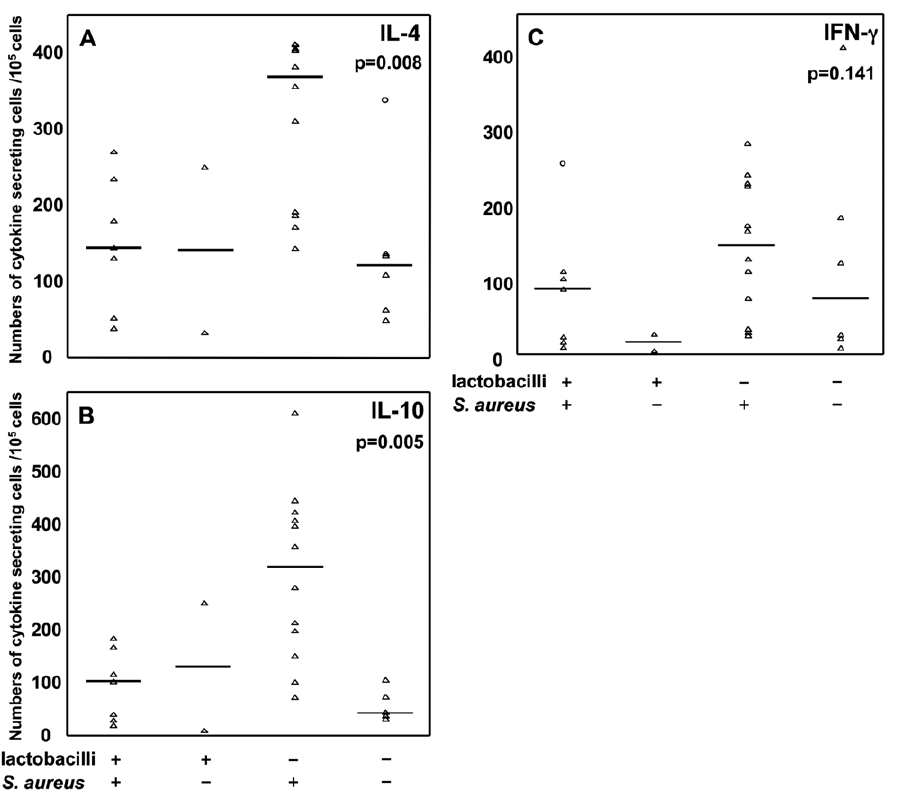
Figure 3. Co-colonization of lactobacilli and S.aureus at 2 weeks and cytokine secreting cells, after invitro PHA stimulation at age two. Infants colonized with both S. aureus and lactobacilli (n=7), none (n=6), only S. aureus (n=12) or only lactobacilli (n=2) at 2 weeks of age in relation to (A) IL-4 2 , (B) IL-10 2 , and (C) IFN- c producing cells. Triangles represent each individual and lines represent median value.